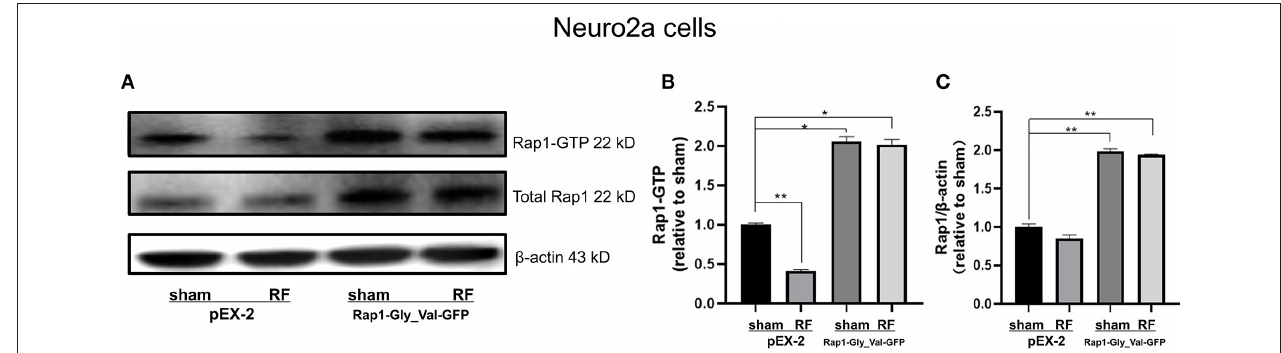
FIGURE 7 | The transfection of constitutively active Rap1 can reverse the decrease in Rap1-GTP induced by 1,800 MHz RF-EMR exposure in Neuro2a cells. Neuro2a cells were transfected by Rap1 constitutively active mutant plasmid (Rap1-Gly_Val-GFP) for 24h. Transfected Neuro2a cells were exposed to RF-EMR for 48h at 4 W/kg. The expression of Rap1-GTP was detected by immunoprecipitation. (A) is the representative bands of Rap1-GTP, Rap1, and β -actin in each group in Neuro2a cells, (B) is the statistical graph made from the data identified according to the gray value and area from the bands. (C) is the ratio of protein expression of Rap1 to